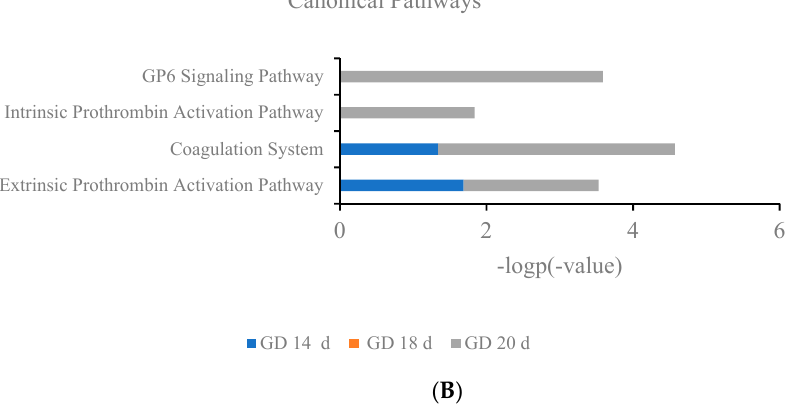
Figure 8. ( A ) Biological processes by IPA ( p value < 0.05) at GD 20 d. ( B ) Changes in coagulation- related pathways at GD 14 d, GD 18 d, and GD 20 d. To assess changes in coagulation-related proteins, their relative abundances were analyzed during pregnancy. MOR8A3 glycoprotein 6 (platelet) was expressed at low levels in early pregnancy but upregulated at GD 14 d and maintained at high levels before delivery (GD 20 d) (Figure 9A). Q7TQ70 fibrinogen alpha chain was an important component in the formation of insoluble fibrin matrix (Figure 9B). Fibrin was one of the main components of blood clots and played an important role in hemostasis, also being upregulated at GD 14 d and remaining higher than the first trimester until delivery. Similarly, fold change of the procoagulant-related proteins became larger over time (Figure 9C). Changes in the coagulation system revealed by the urinary proteome were consistent with reported changes before labor.